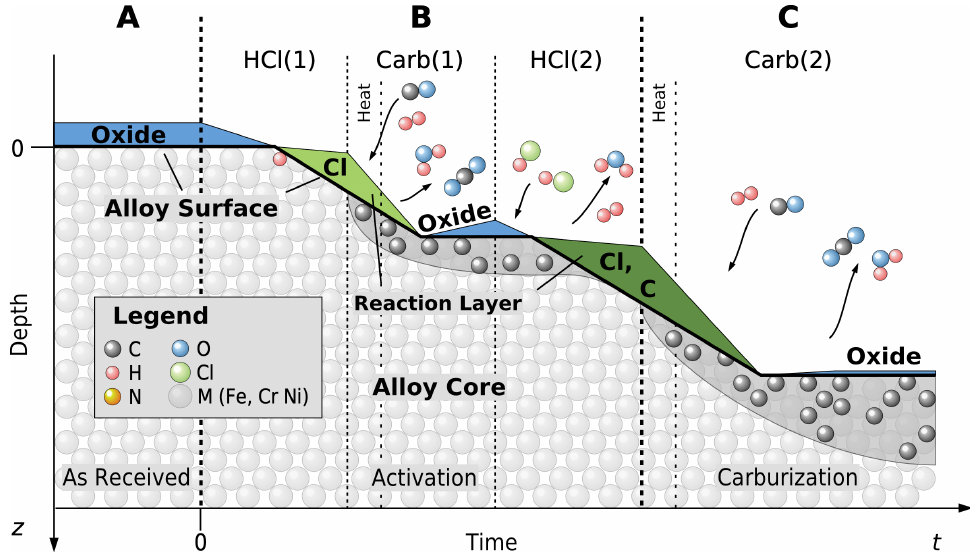
Figure 14. Model for the microscopic mechanism of A S —“double HCl”—surface activation and subsequent low-temperature gas-phase carburization of austenitic Cr-bearing alloys. The bold line shows the height z of the alloy surface as a function of time t . ( A ) Initial state, alloy surface passivated by oxide film. ( B ) ”Double HCl” activation, consisting of HCl(1), Carb(1), HCl(2), see Table 1. ( C ) Continuous low-temperature carburization,